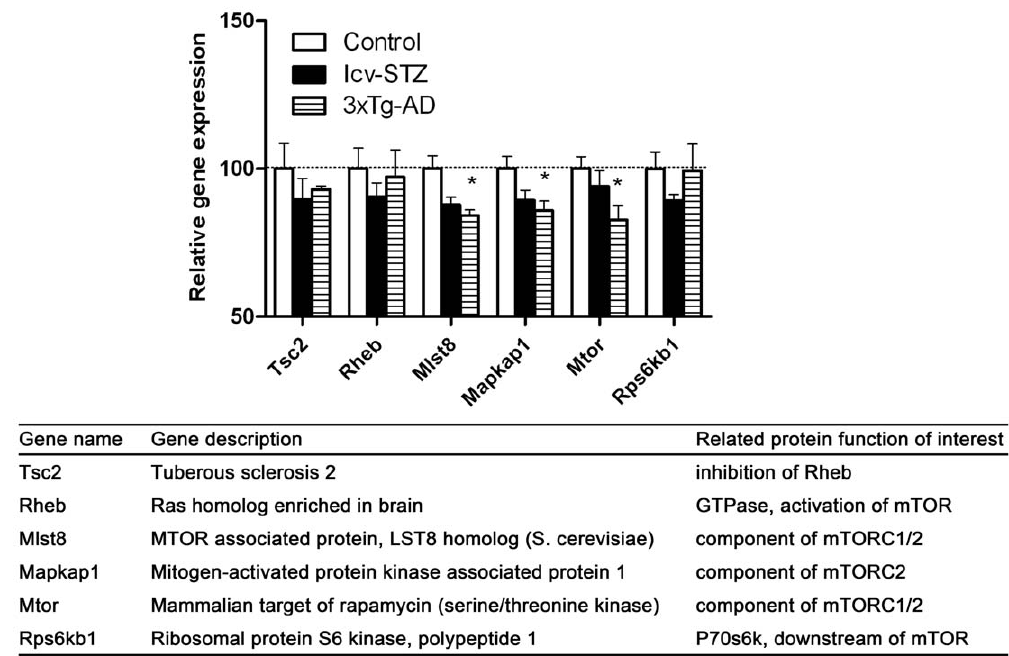
Figure 9. mTOR signaling–related gene expression in the hippocampus.